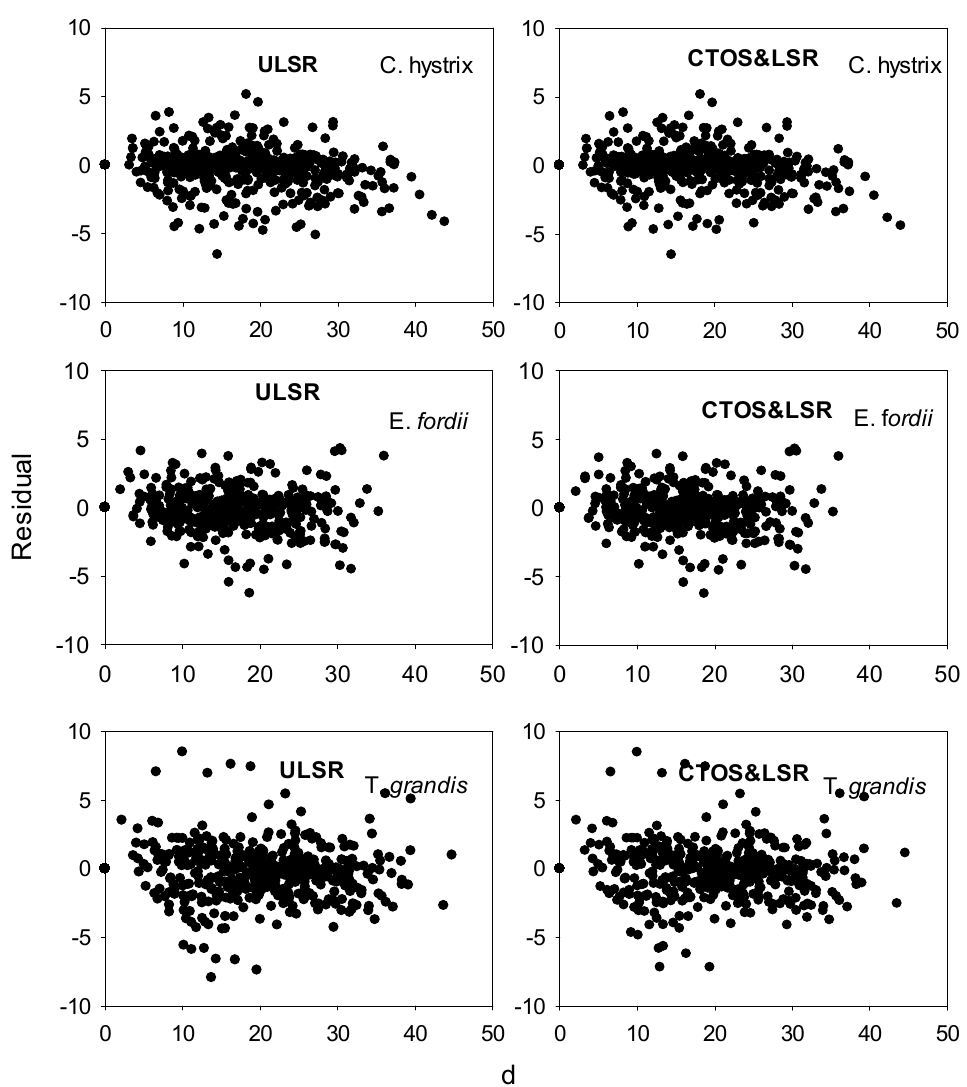
Figure 6. Residuals of the Equation (1) for the three tree species C. hystrix , E. fordii. and T. grandi using both the combination method of constrained two ‐ dimensional optimum seeking and least square regression (CTOS & LSR) and the unconstrained least square regression (ULSR) plotted against the observed values based on cross ‐ validation.